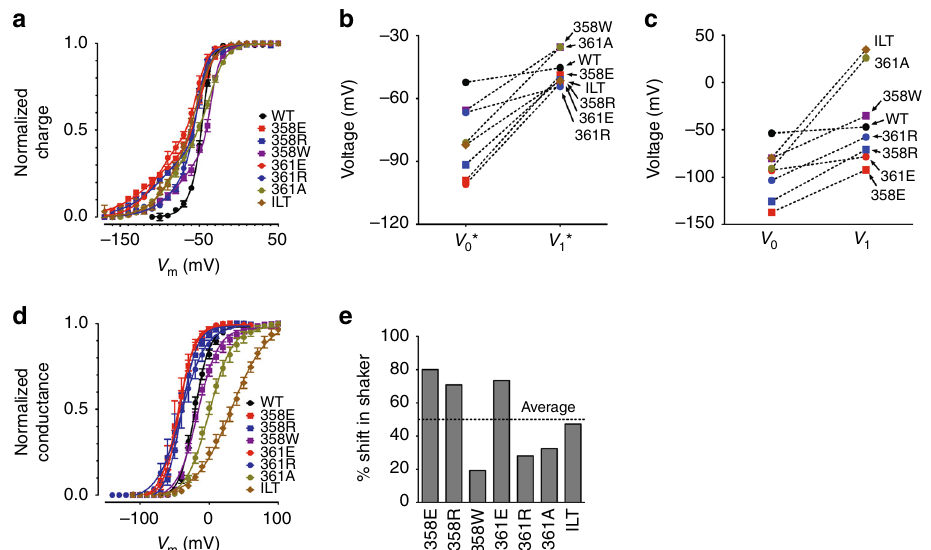
Fig. 5 wt-PD Shaker dimers (no W434F mutation) and nonconductive Shaker dimers (all PD mutated with W434F) show independent VSD domains. a Q – V curves are shown for all nonconductive dimers studied including dimers with only PD W434F and the ones possessing two VSD mut , indicated in the inset in a color/shape code. The curves were fi tted with two independent two-state models for the generation of two voltage dependences values, V 0 * and V 1 *. These values are plotted in b and for comparison, V 0 and V 1 (from nonconductive Shaker) are plotted in c . d G – V curves from wt-PD Shaker dimers possessing only VSD wt and the ones possessing two VSD mut , similarly indicated in the inset in a color/shape code. Data were fi tted with a two-state model and the values of the G – V midpoints ( V 1/2 *) were used to calculate the shifts produced by the mutations in the VSD as compared with V 1/2 * from wt-PD Shaker dimers that only contains VSD wt ( e ). A horizontal dotted line shows the overall average value of the % shift and its value is 49.8%. All data points are the average of 4 – 6 independent experiments. The vertical bars in a and d are the standard error of the mean. The plots in b and c were omitted of error bars for clarity. Continuous lines over the data points represent the best fi t of two independent two-state models for Q – V curves in a and a two-state model for G – V curves in